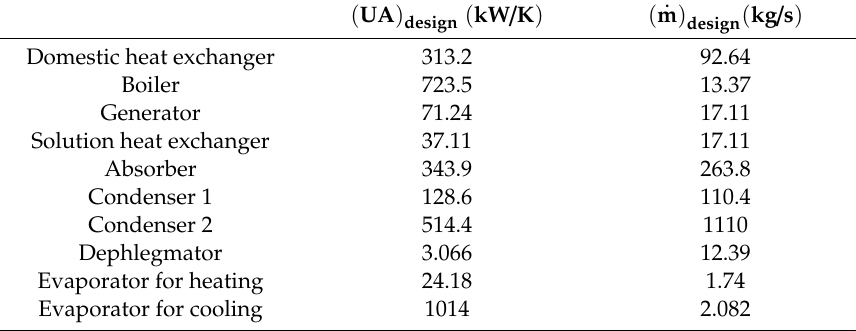
Table 2. The calculated parameters of heat exchangers in design mode.